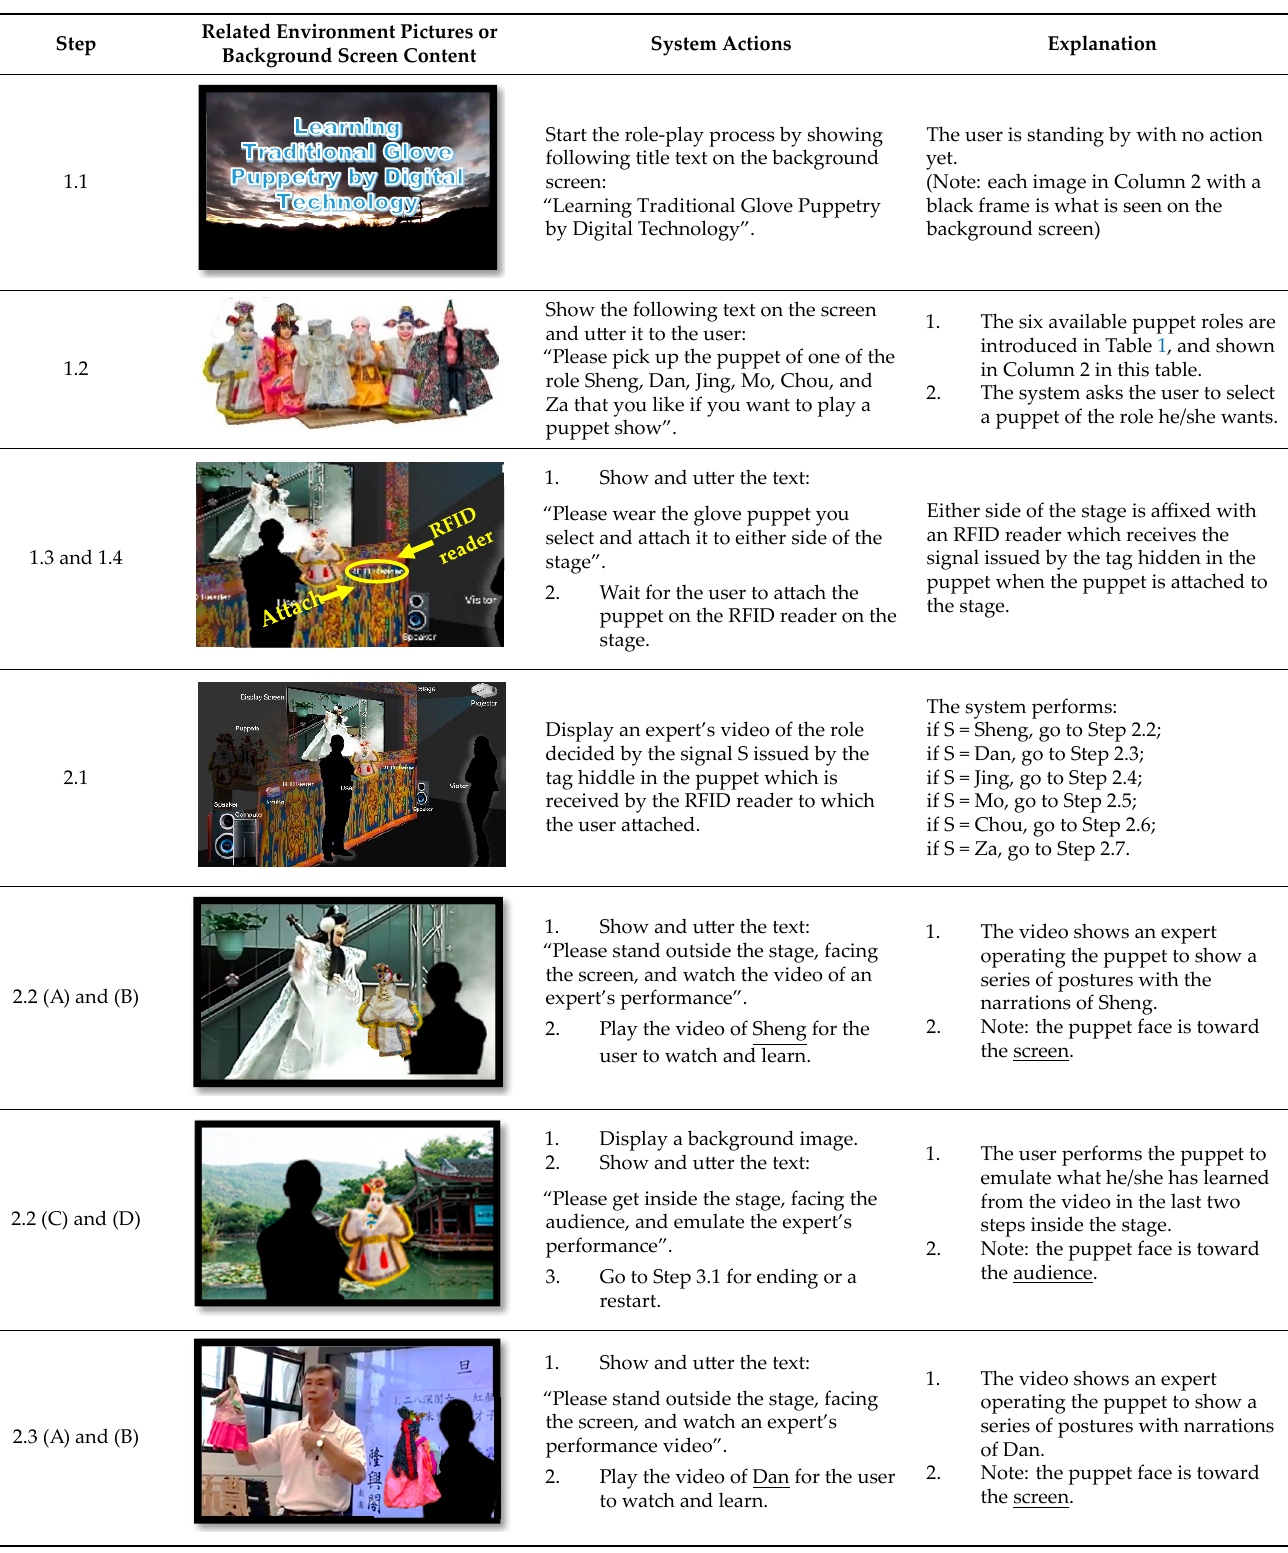
Table 3. The storyboards of the operation process of the puppet show on the proposed